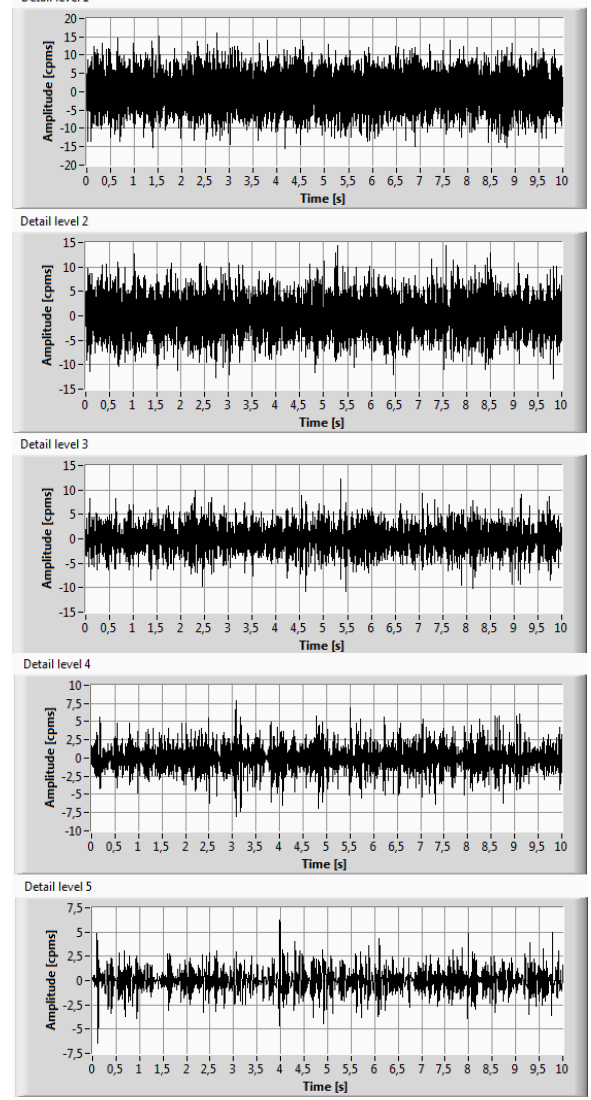
Fig. 8. Decomposition of the x ( n ) signal into high-frequency components (details) in the LIW5